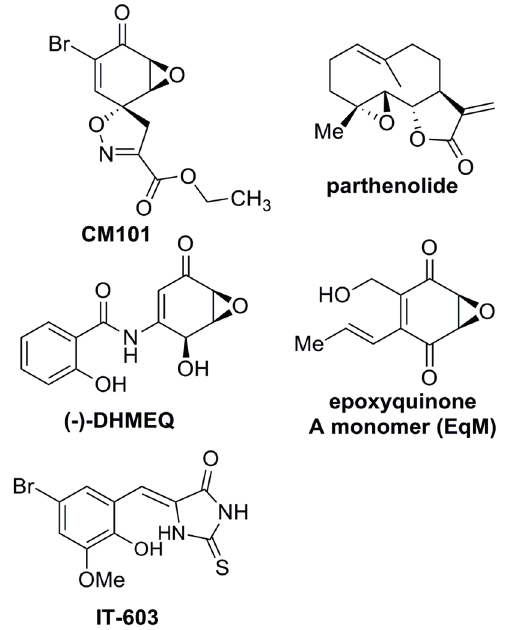
of CM101, parthenolide [18,19], DHMEQ [( − )-dehydroxymethylepoxquinomicin] [20], epoxyquinone A monomer [21], and IT-603